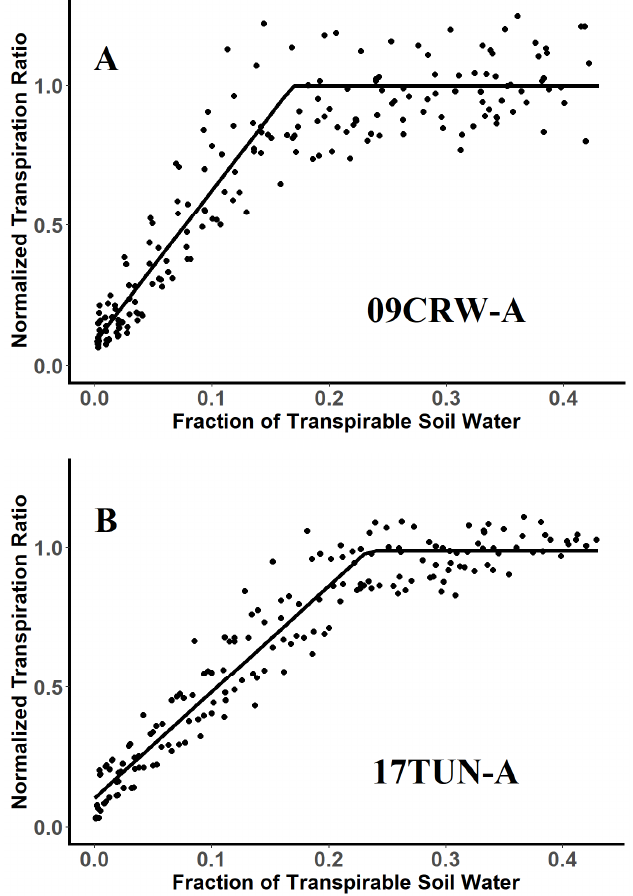
Figure 2. Relationship between normalized transpiration ratio (NTR) and fraction of transpirable soil water (FTSW) during the soil drying cycle for S -metolachlor-susceptible (09CRW-A) (panel A ) and -resistant (17TUN-A) (panel B ) accessions of Palmer amaranth ( Amaranthus palmeri (S.) Wats.); greenhouse experiment, Shult Agricultural Research & Extension Center, University of Arkansas, Fayetteville, AR, USA, in 2021.